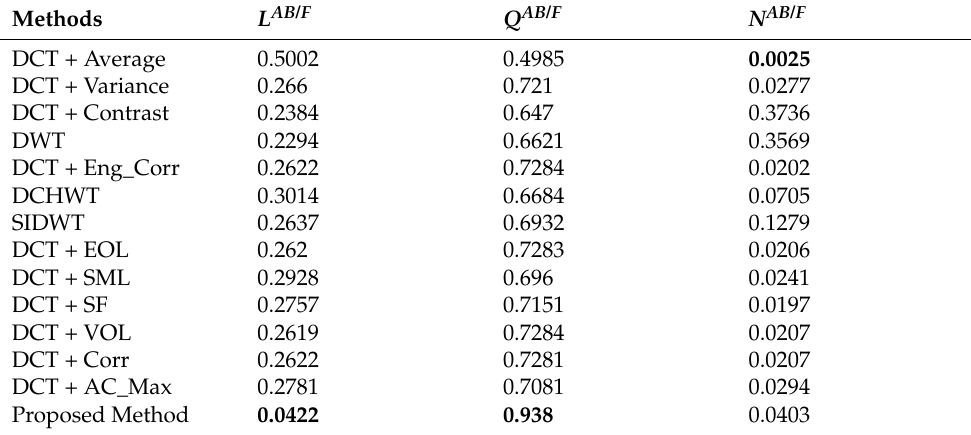
Table 19. The outcomes for the book image and comparisons with existing techniques in the literature ([26]).